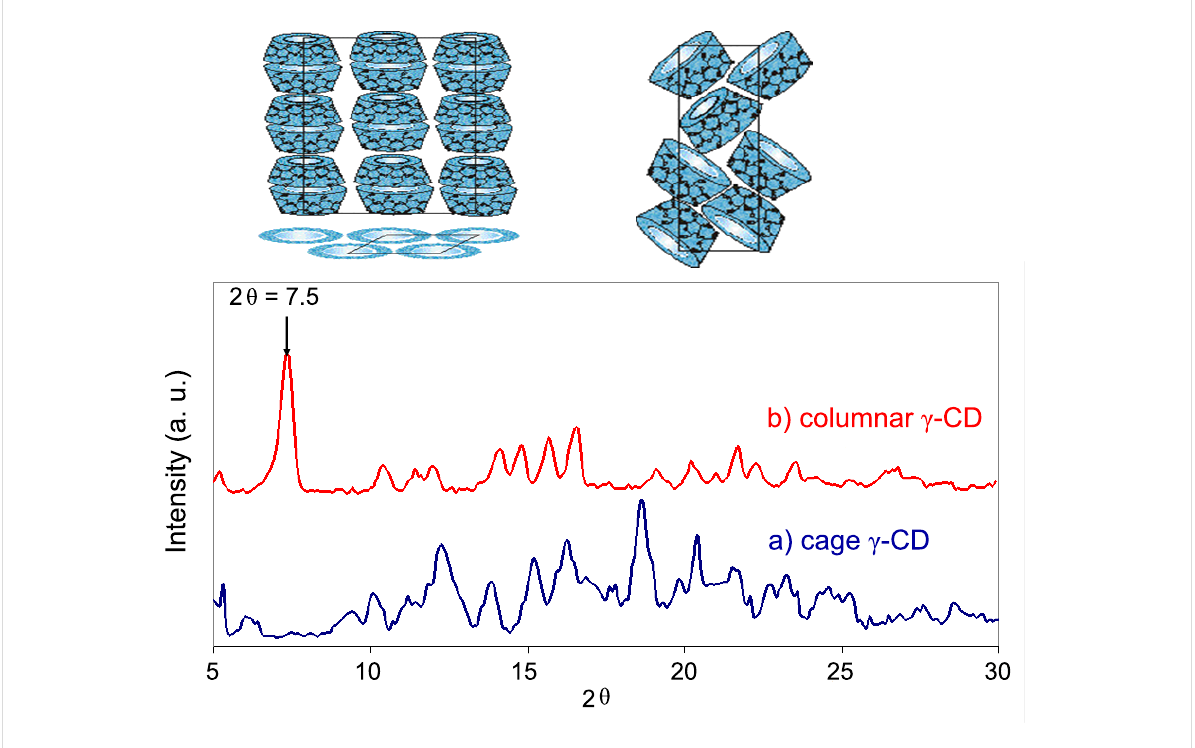
Figure 2: Crystal structures and wide-angle X-ray diffractograms of neat (a) cage and (b) columnar IC γ - CD